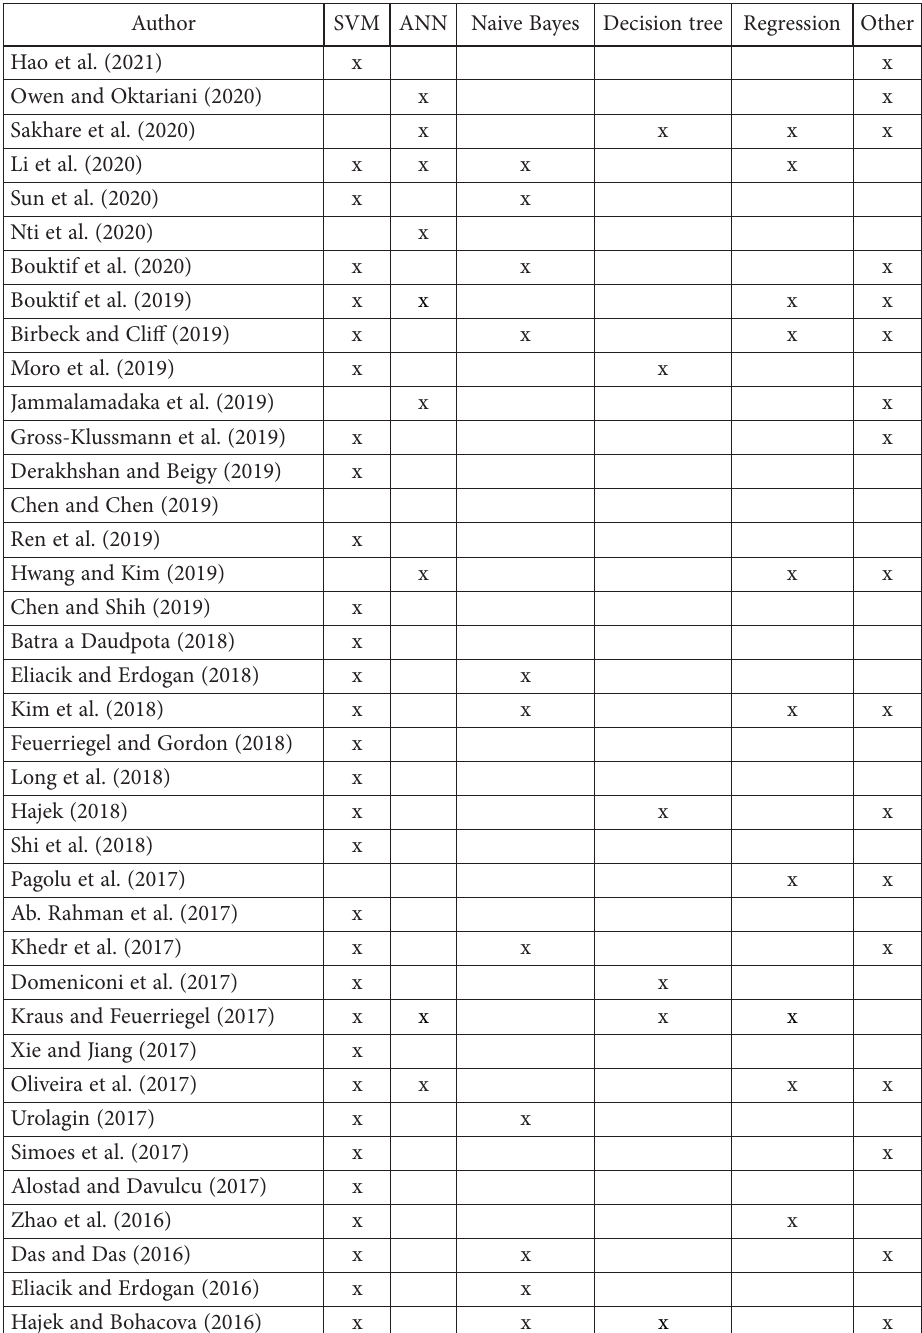
Table 3. Type of classification algorithm (source: Janková,